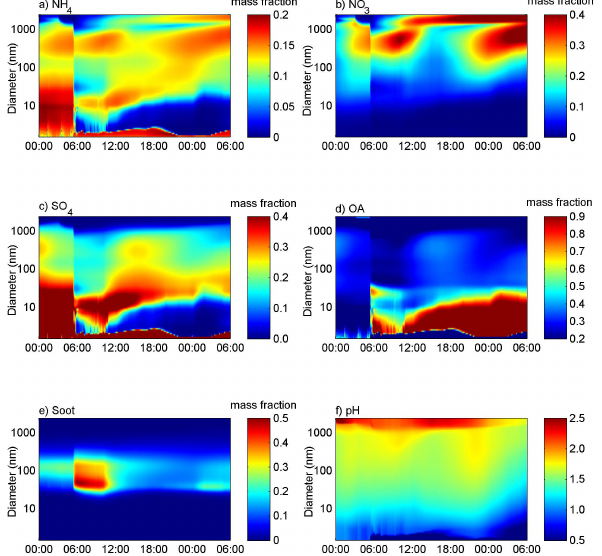
Fig. 10. Modeled PM2.5 masses of ammonium (a) , nitrate (b) , sul- fate (c) , organic aerosol (d) , soot (e) and the relative humidity (f) , from 6h upwind of Malm¨o (00:00) until 24h downwind of Malm¨o, in the vertical direction (0–2000ma.g.l.), in the center of the urban plume. The mixing height along the trajectory is also